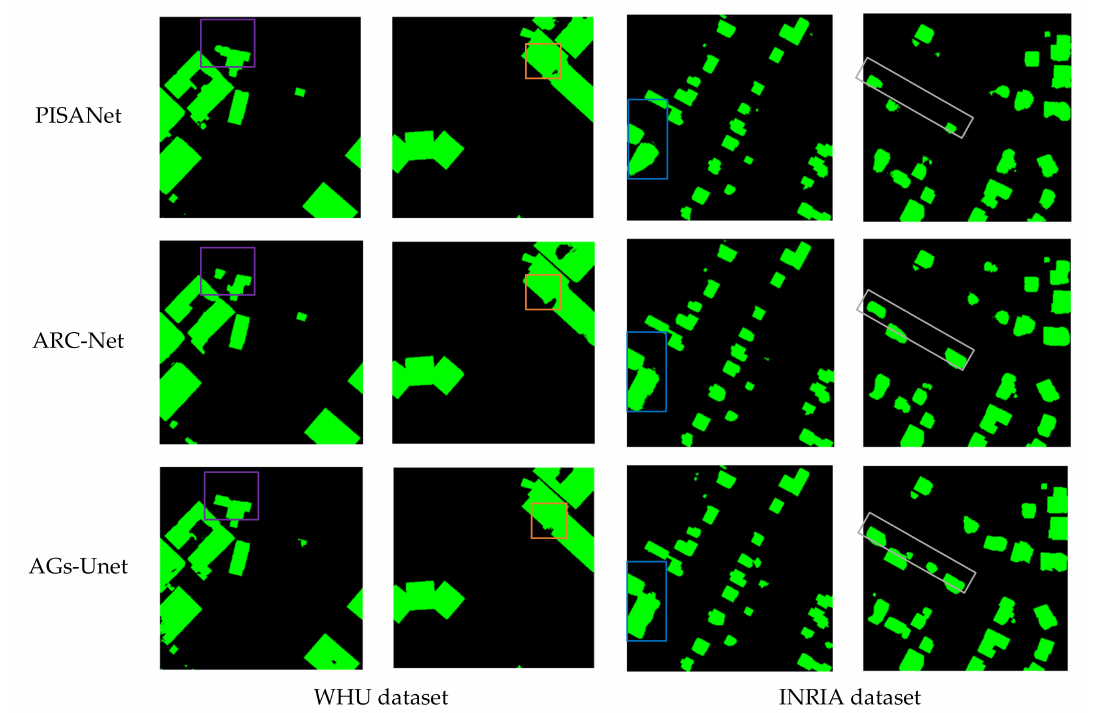
Figure 8. Comparison of extraction results of each model building in test dataset. The first two rows are aerial images and ground truth, respectively. Rows 3–8 are building extraction results of SegNet, FCN8s, DANet, U-Net, PISANet, ARC-Net, and our proposed AGs-Unet, respectively. The green and black pixels of the maps represent the predictions of true positive and true negative,